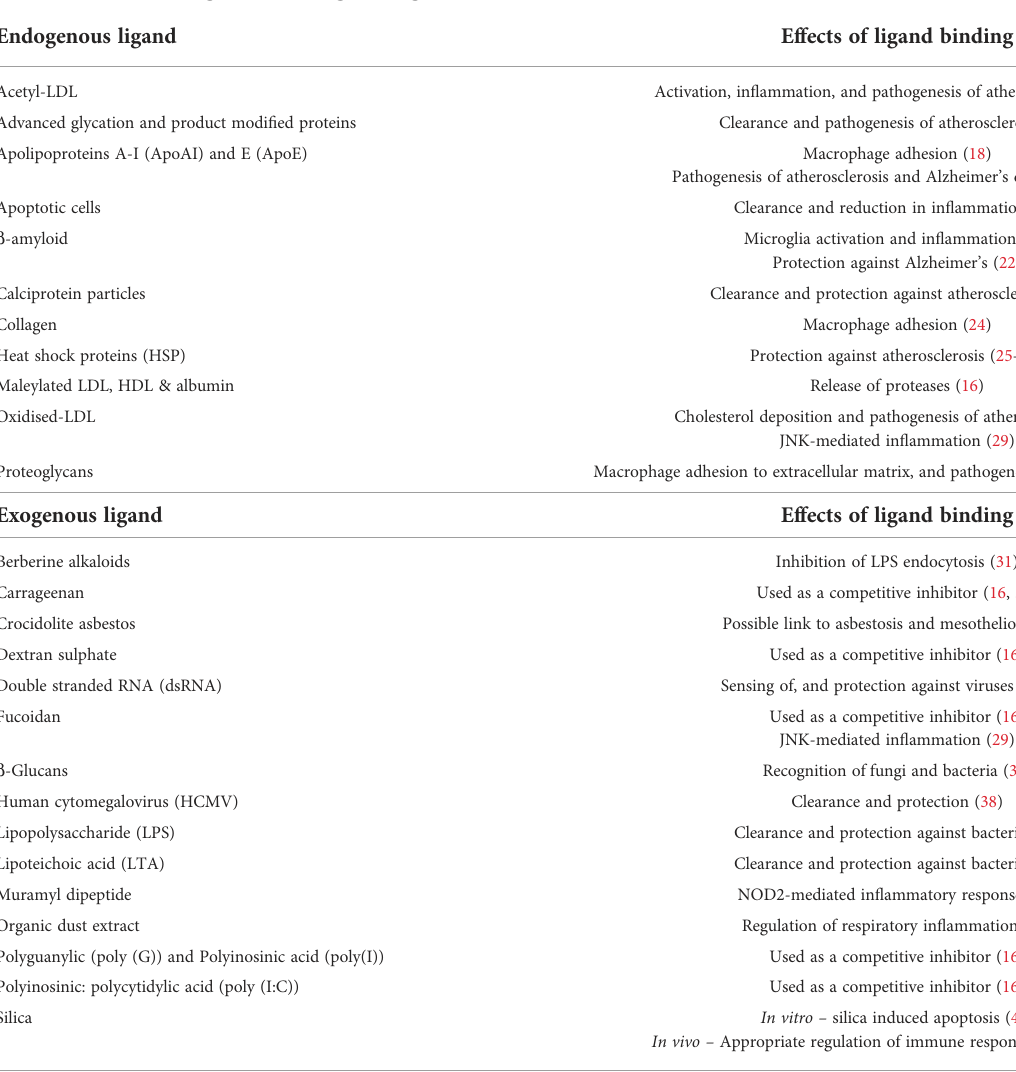
TABLE 1 List of the endogenous and exogenous ligands known to bind to MSR1 and their